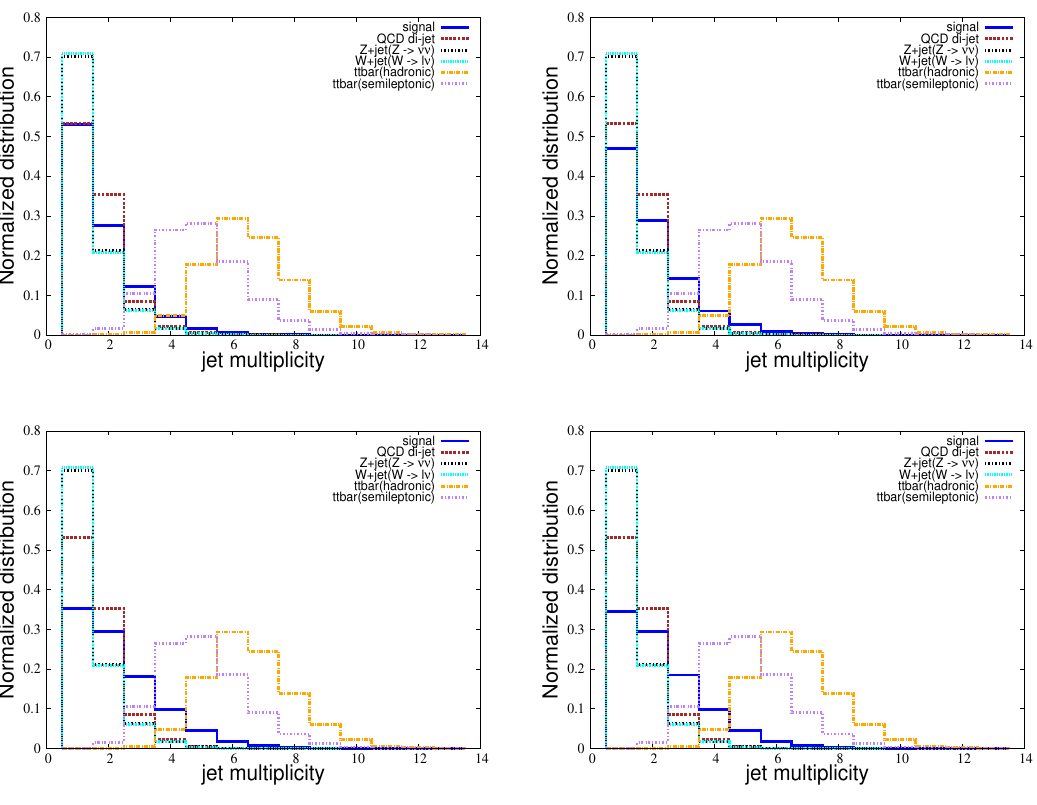
Figure 9 . Jet multiplicity distribution for gluon fusion signal and background processes, Type I BP I (top left), Type I BP II (top right), Type II BP I (bottom left) and Type II BP II (bottom